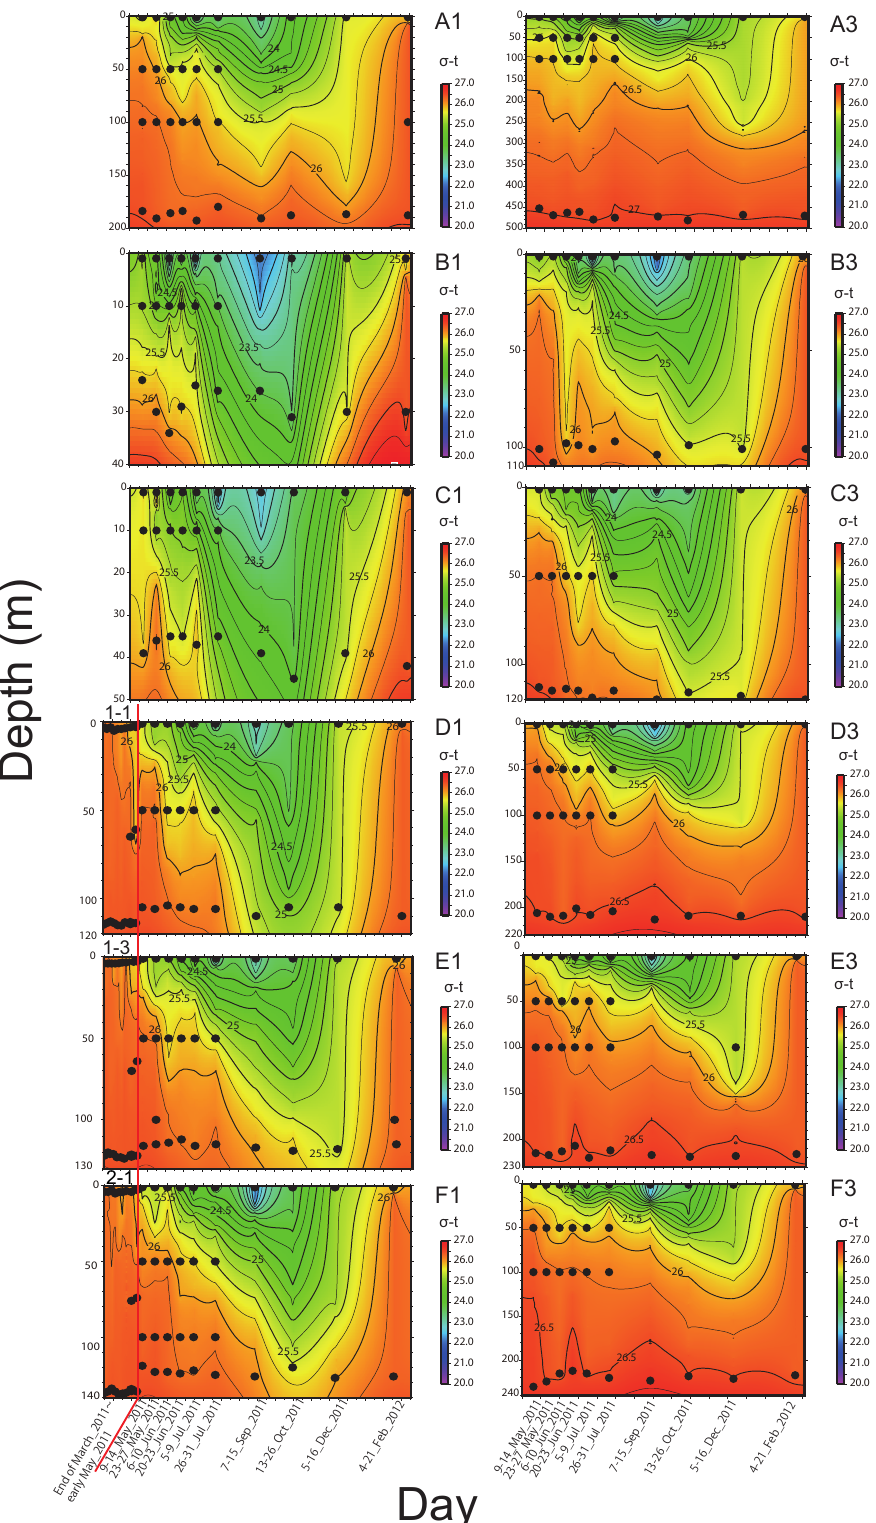
Fig. 6. Vertical distributions of σ t and their temporal changes. Solid circles indicate sampling depths. Data taken at Stns. 1-1, 1-3 and 2-1 in Phase 1, which were at almost the same locations as Stns. D-1, E-1 and F-1, respectively, were also plotted on the left side of the red line in the correspondent